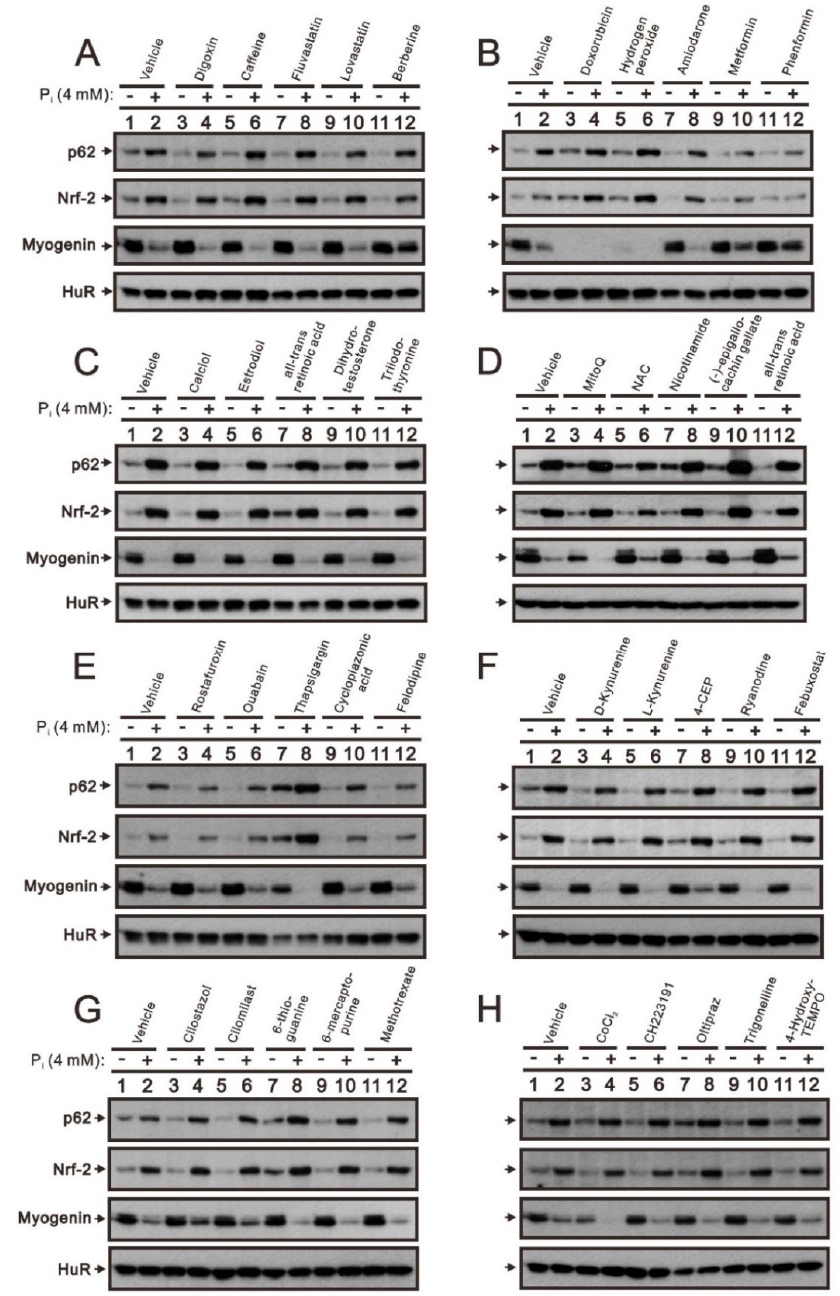
Figure 3. The drug screening platform for the rescue effect on the high P i in differentiated C2C12 cells. After induction of differentiation by culturing C2C12 cells in differentiation medium for 3 days, differentiated C2C12 cells were treated with the indicated drug (( A ): vehicle, digoxin, caffeine, fluvastatin, lovastatin, and berberine; ( B ): vehicle, doxorubicin, hydrogen peroxide, amiodarone, metformin, and phenformin; ( C ): vehicle, calciol, estradiol, all-trans retinoic acid, dihydrotestosterone, and triiodothyronine; ( D ): vehicle, MitoQ, NAC, nicotinamide, (-)-epigallocachin gallate, and all-trans retinoic acid; ( E ): vehicle, rostafuroxin, ouabain, thapsigargin, cyclopiazonic acid, and felodipine; ( F ): vehicle, D-kynurenine, L-kynurenine, 4-CEP, ryanodine, and febuxostat; ( G ): vehicle, cilostazol, cilomilast, 6-thioguanine, 6-mercaptopurine, and methotrexate; ( H ): vehicle, CoCl 2 , CH223191, oltipraz, trigonelline, and 4-hydroxy-TEMPO) with 4 mM P i for 24 h. Cell lysates were subject to immunoblot analysis against p62, Nrf2, and myogenin proteins. HuR was a protein loading control.